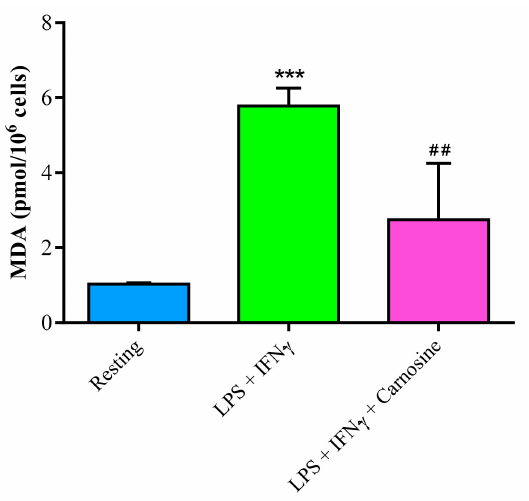
Figure 6. Concentration of MDA in resting (control) RAW 264.7 macrophages and in macrophages stimulated with LPS (100 ng / mL) + IFN- γ (600 U / mL), in the absence or in the presence of carnosine (20 mM). Values are means ± SD of three to four independent experiments. *** p < 0.001 vs. resting; ## p < 0.01 vs. LPS + IFN- γ